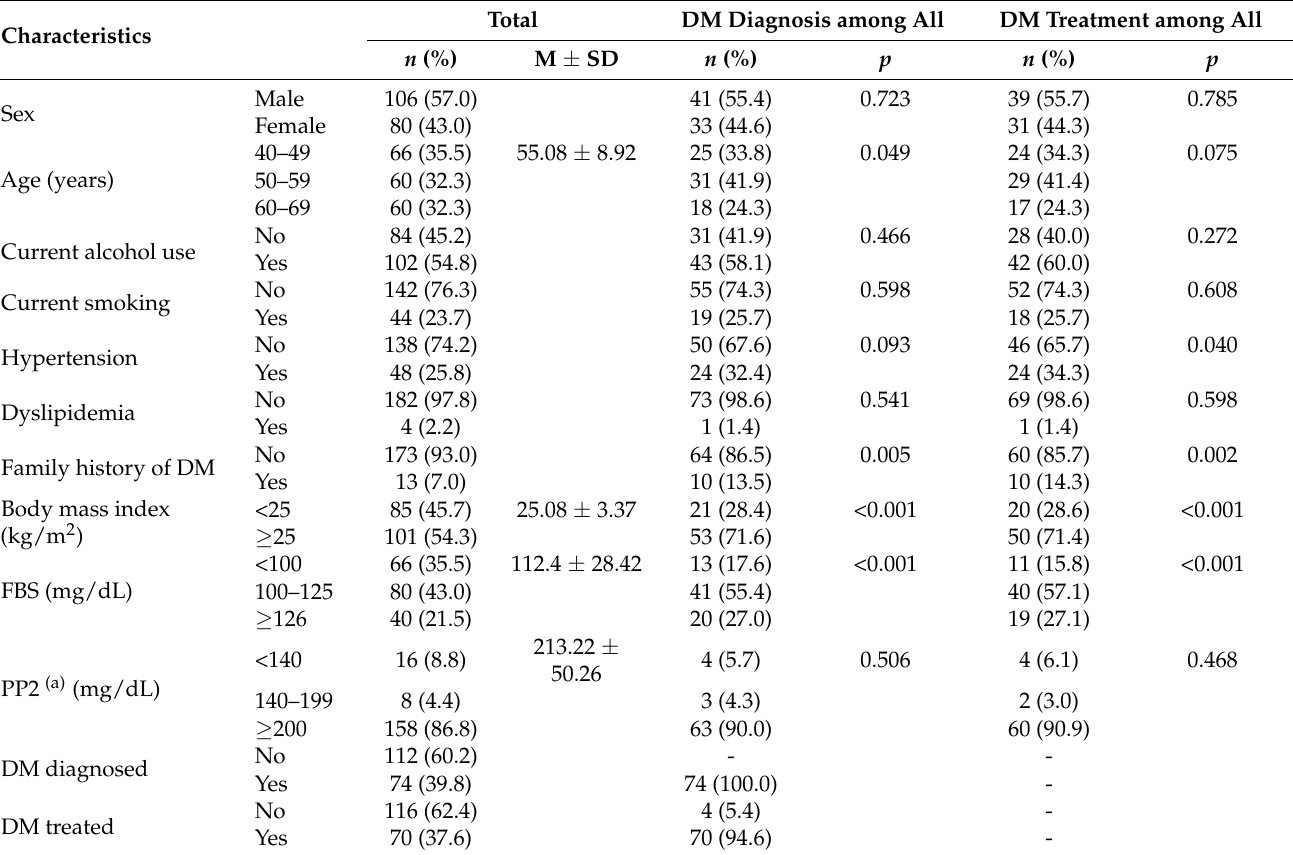
Table 1. Participants’ characteristics at the 1st follow-up (N =